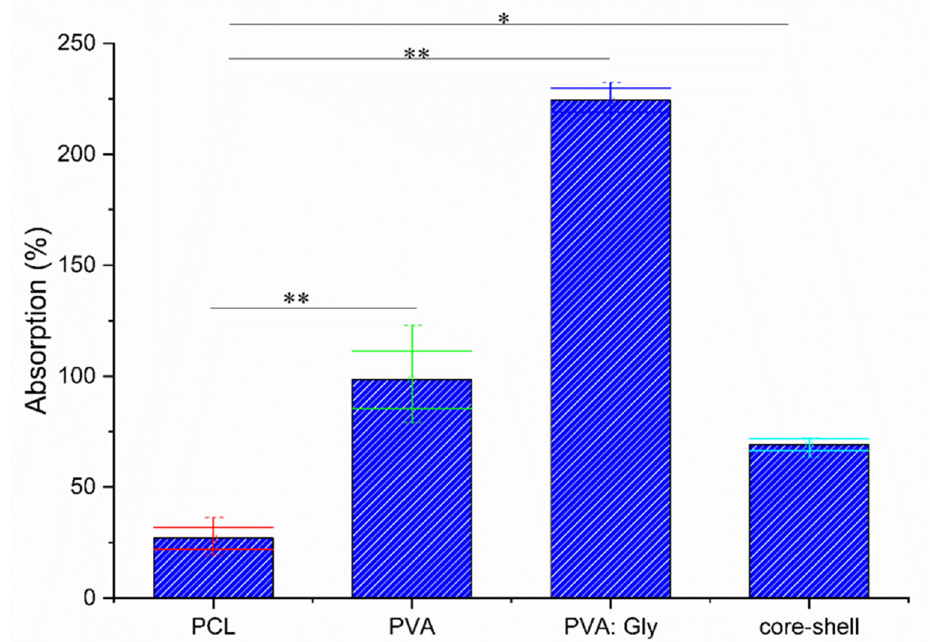
Figure 9. Absorption % of the PCL, PVA, PVA:Gly, and core-shell membranes. All readings are presented as remaining weight% ± SD . ANOVA; ** p < 0.001 and * p < 0.01.